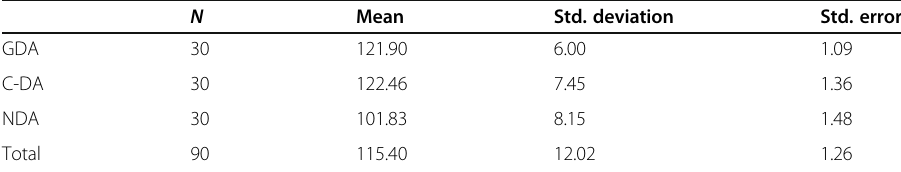
Table 3 Descriptive statistics for comparing the speaking accuracy post-test scores of the GDA, C- DA, and N-DA learners N Mean Std. deviation GDA